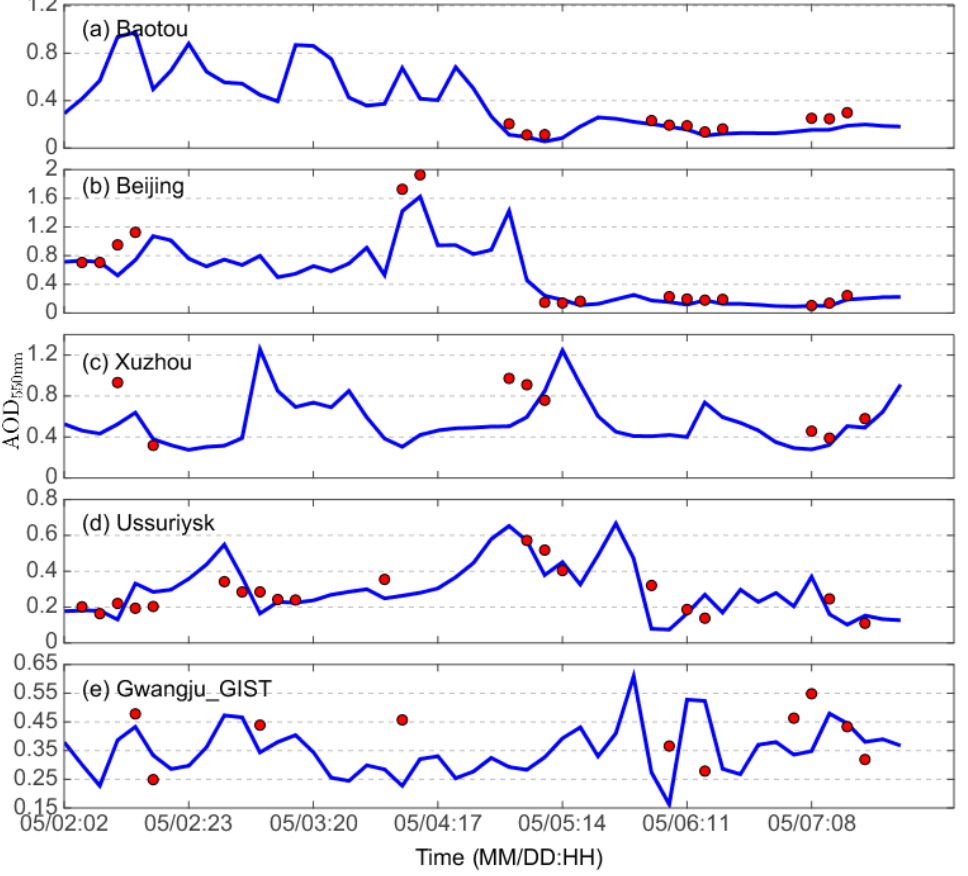
Figure 4. Hourly average spatial distribution of the AOD at five typical AERONET stations during the period 2–7 May 2017 (Beijing time). The red dots represent the AERONET hourly average AOD and the blue curve represents the MERRA-2 AOD. (sub-graph ( a – e ) respectively describe the hourly average spatial distribution of the AOD at Baotou, Beijing, Xuzhou, Ussuriysk, and Gwangju_GIST)